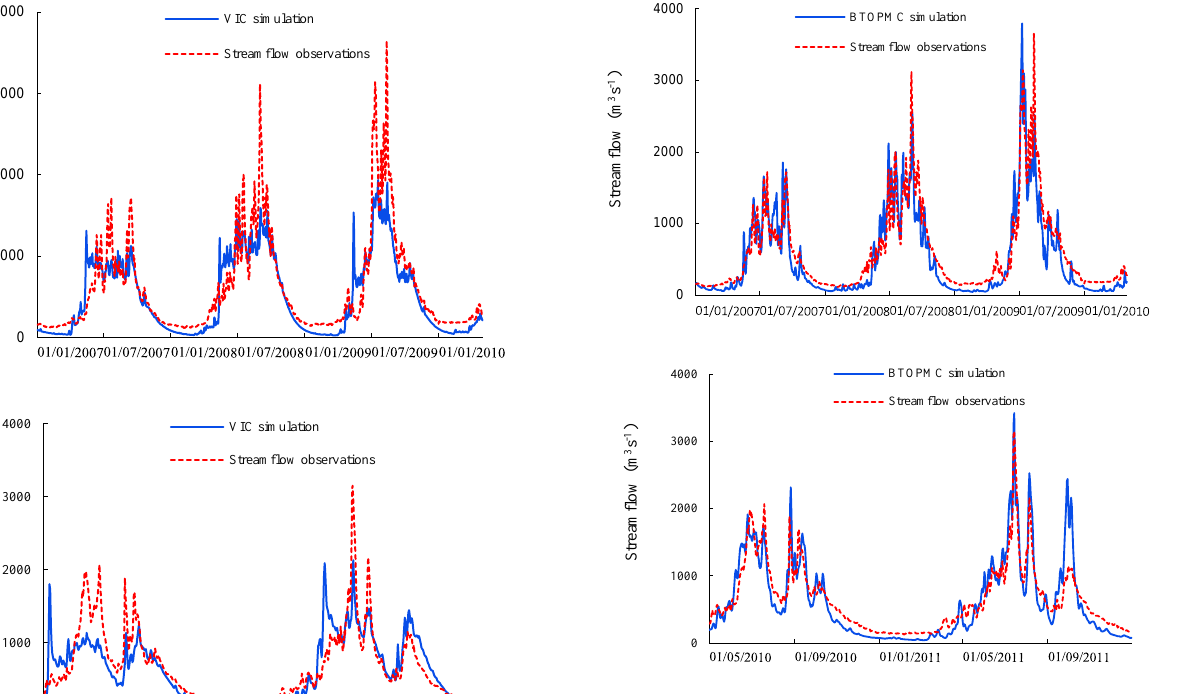
Figure 5. BTOPMC simulated streamflow for the basin in both the calibration and validation